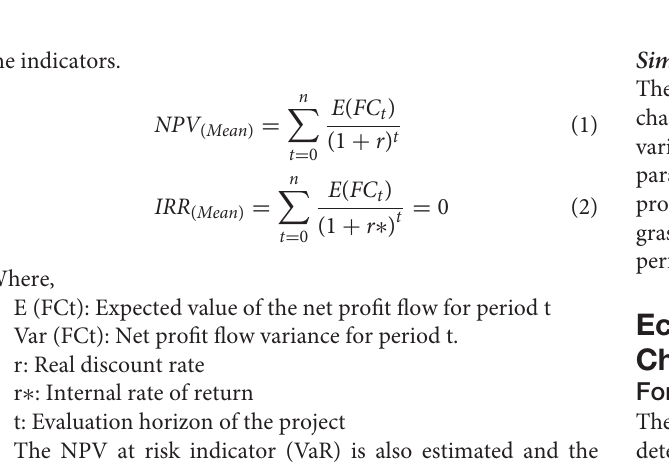
FIGURE 1 | Consumer Price Index (CPI) and Producer Price Index (PPI) behavior of milk in the face of climatic events. Source: Own elaboration based on DANE (2020b,c).